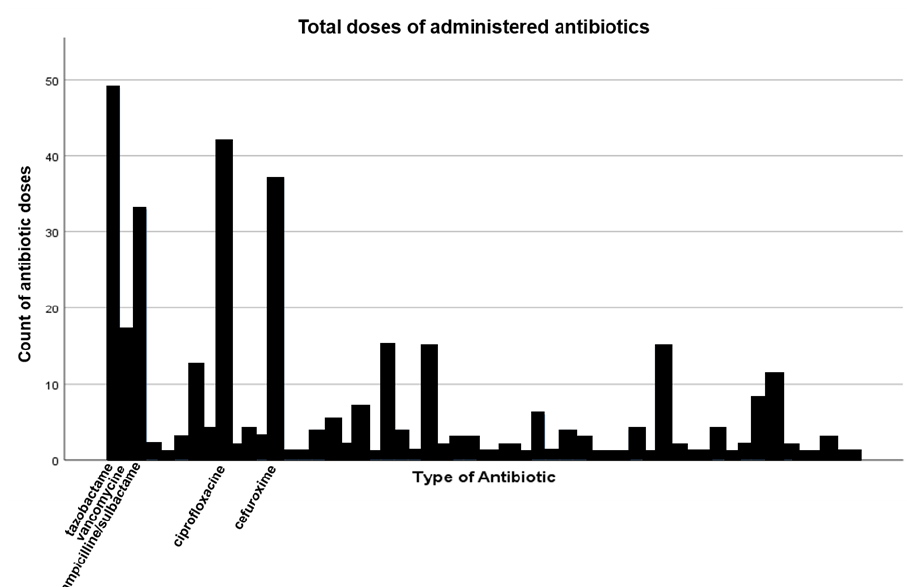
Figure 4. Total number of different antibiotic doses administered.